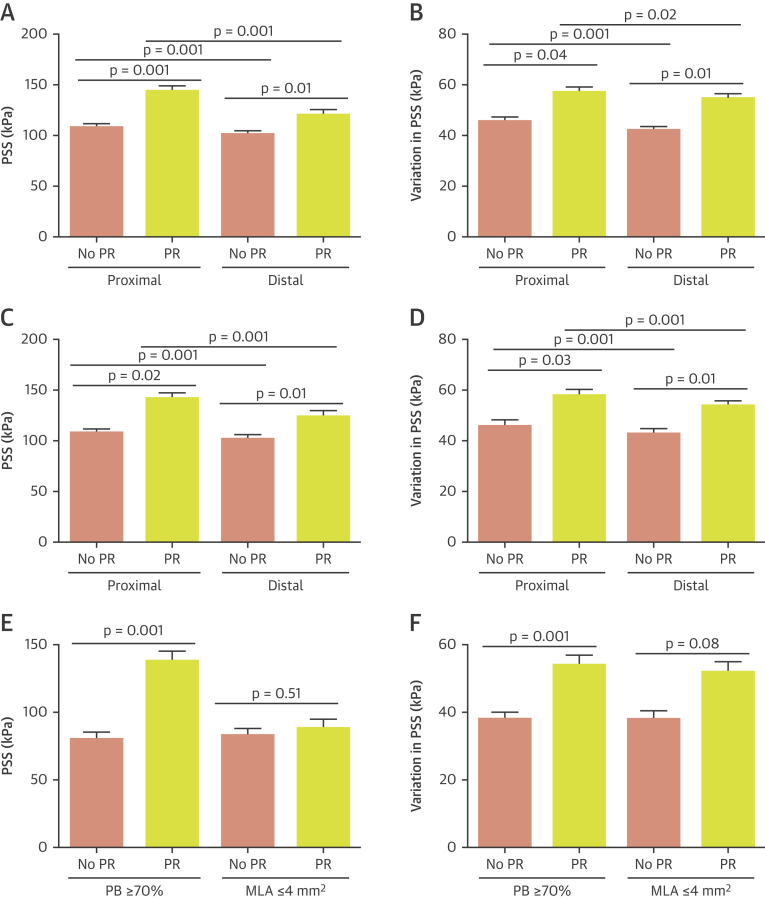
PSS and Variation in PSS in VH-FAs With and Without Rupture(A and B) PSS and variation in PSS in the proximal and distal segments of VH-FAs with and without plaque rupture. (C and D) PSS and variation in PSS in the proximal and distal segments of VH-TCFAs with and without PR. (E and F) PSS and variation in PSS in VH-TCFAs with PB ≥70% or MLA ≤4 mm2 with and without PR. MLA = minimal luminal area; PR = plaque rupture; VH-TCFA = virtual histology thin-cap fibroatheroma; other abbreviations as in Figures 1 and 4.